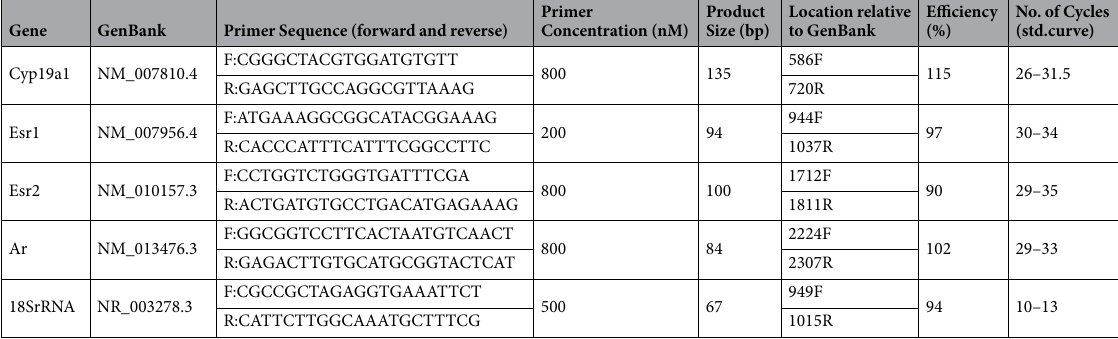
Table 1. Primer sequences and conditions of qPCR